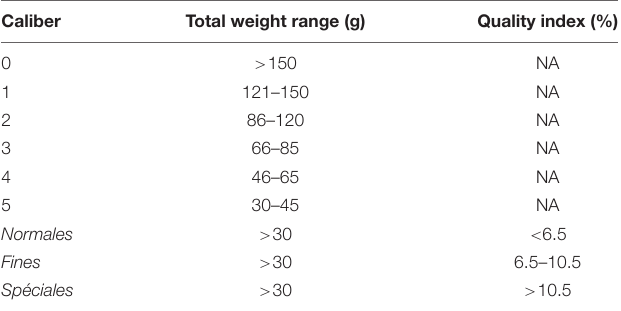
TABLE 2 | Total Pacific oyster weight ranges and quality indices corresponding to French market calibers and classes (AFNOR, 1985; Gosling, 2003). Caliber